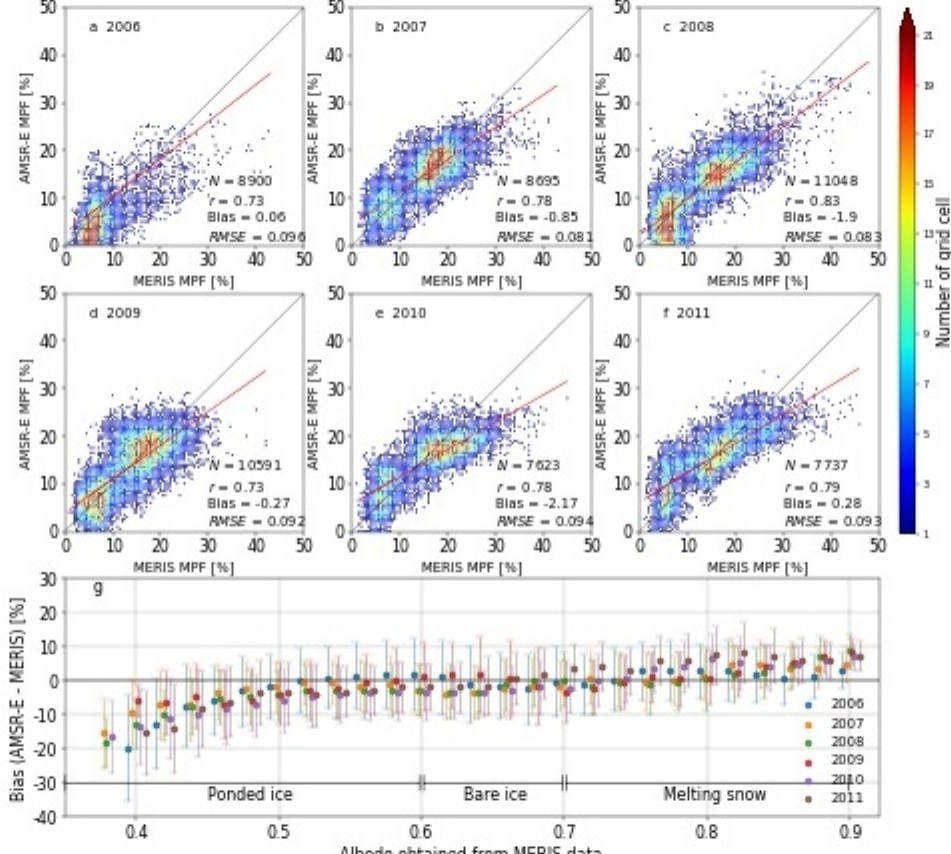
Figure 6. ( a – f ) Relationship between the Medium Resolution Imaging Spectrometer (MERIS) and AMSR-E MPFs. The red line: linear regression, color bar: number of grid cells (N), r : correlation coe ffi cient, RMSE: root mean square error. ( g ) Average bias between AMSR-E and MERIS MPFs at each albedo with 0.02 bin size. The albedo was obtained from the products of MPF and spectral sea ice albedo from MERIS data. The error bars are standard deviation of the bias.